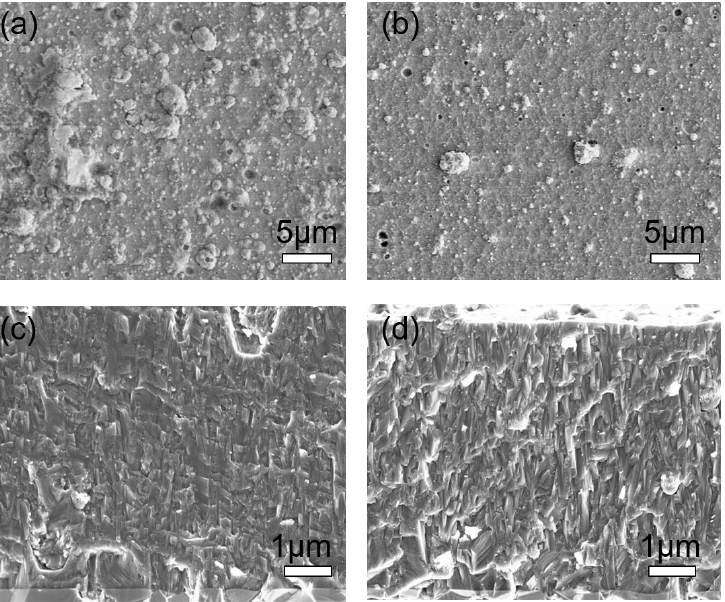
17 Figure 17. Surface and cross-sectional morphology of (AlCr)N monolayer coatings deposited for ( a , c ) at 2.5 Pa N 2 and for ( b , d ) at 7.5 Pa N 2 , for illustration of relative